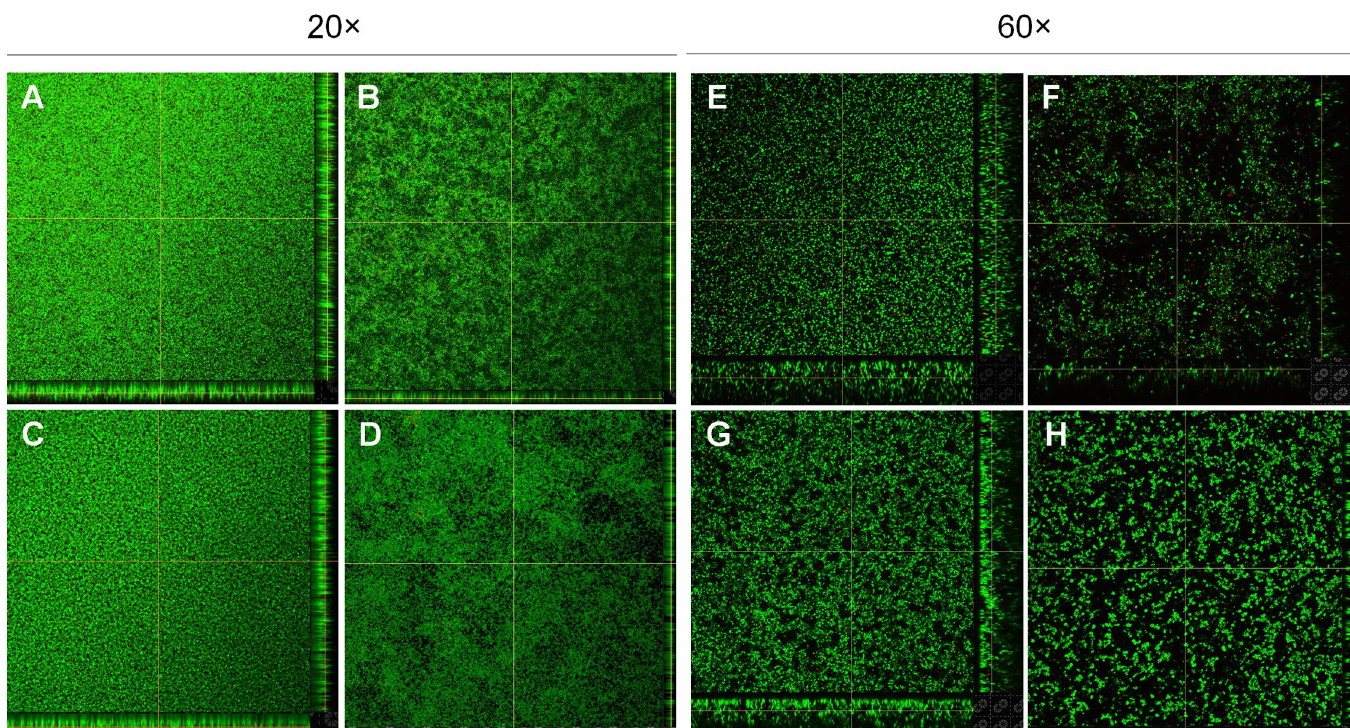
Fig 2. Confocal laser scanning microscopy of biofilms. M . haemolytica (D153; 20 × objective lens: A and B; 60 × objective lens: E and F) and S . aureus Newbould 305 (NB305; 20 × objective lens: C and D; 60 × objective lens: G and H) were grown in BHI broth (A, C, E, and G) and colorless RPMI 1640 (B, D, F, and H) in 96-well plates at 37˚C for 48 h (NB305) to 72 h (D153). Biofilms grown on polystyrene plastic surfaces (A-D) and polymer coverslips (E-H) were stained with Filmtracer ™ LIVE/DEAD ™ Biofilm Viability stains (SYTO 9 and propidium iodide) and multiple z -stacks were collected per each sample and three-dimensional images were produced using Nikon software. One representative biofilm image out of two independent experiments performed in triplicate wells are shown.